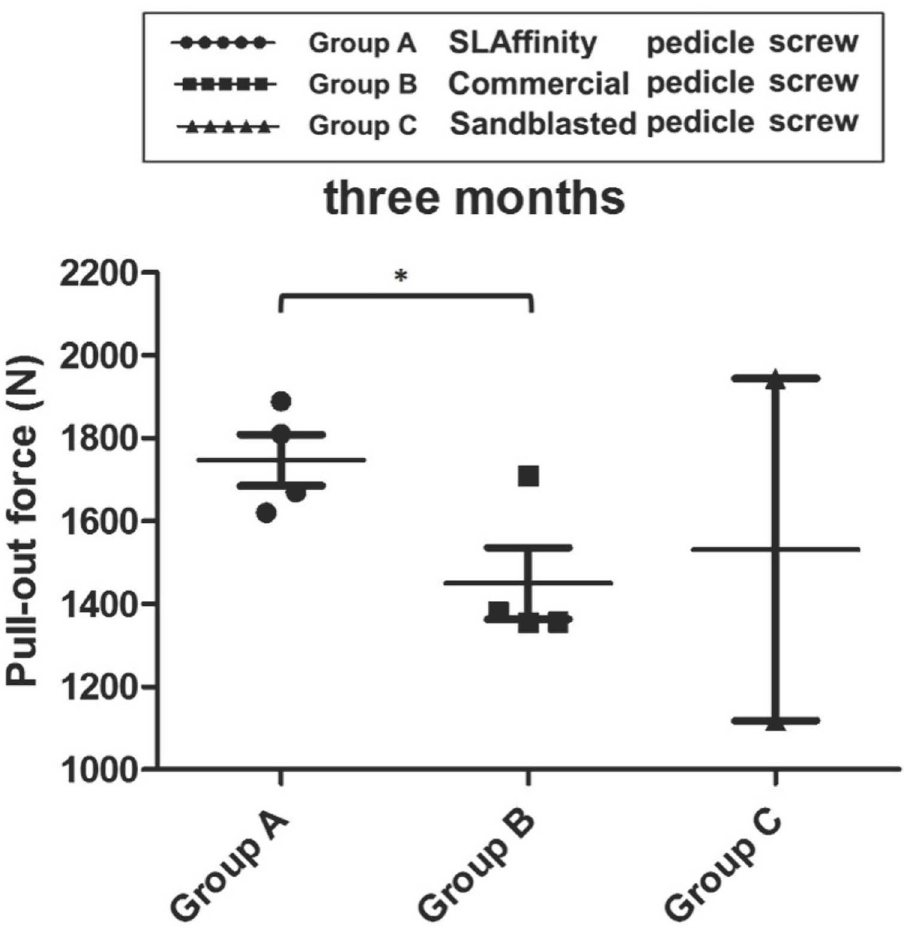
Fig 11. Comparison of pull-out force among different groups 3 months after implantation. * : p < 0.05.